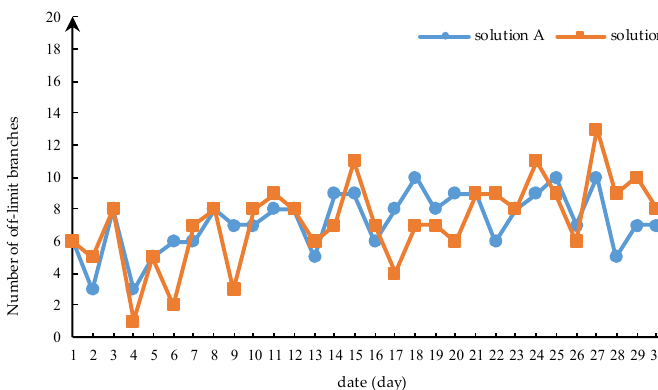
Figure 6. DC transmission power.